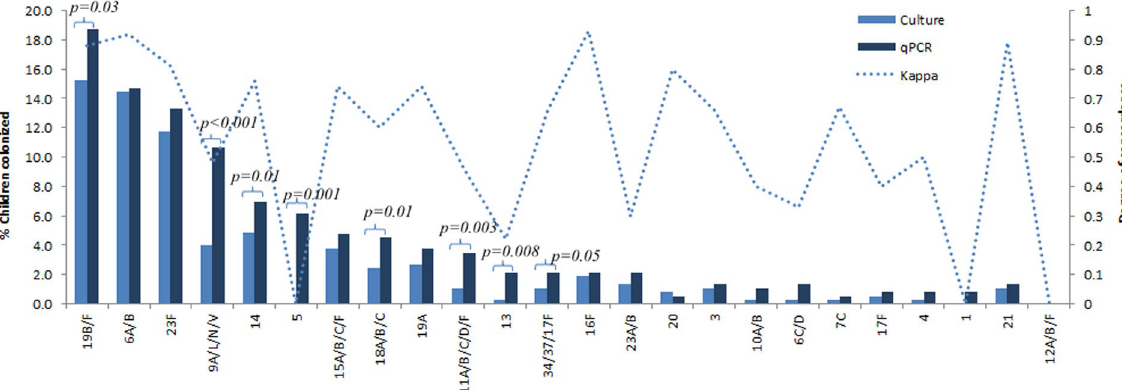
Figure 3. Overall prevalence of nasopharyngeal (NP) pneumococcal colonization as detected by traditional culture and quantitative PCR (qPCR) in a PCV-unvaccinated, HIV-uninfected cohort. Concordance between traditional culture and quantitative PCR (qPCR) were calculated using McNemar’s test with serogroups detected by qPCR included as serotypes. p -values of < 0.05 were considered significant. Serogroup 6A/B (54): 35.2% Serotype 6A and 64.8% Serotype 6B on culture method. Serogroup 6C/D (1): 100% Serotype 6C on culture method. Serogroup 11/A/B/C/D/F (4): 100% were serotype 11A on culture method. Serogroup 15/A/B/ C/F (14): 21%, 64.3%, and 14.2% were serotypes 15A, 15B and 15C on culture method respectively. Serogroup 18A/B/C (9): 100% were serotype 18C on culture method. Serogroup 19B/F (58): 8.6% were serotype 19B and 91.4% were serotype 19F on culture method. Serogroup 23A/B (5): 60% were serotype 23A and 40% were serotype 23B on culture method. Serogroups 34/37/17A (4): 100% were serotype 34 on culture method.